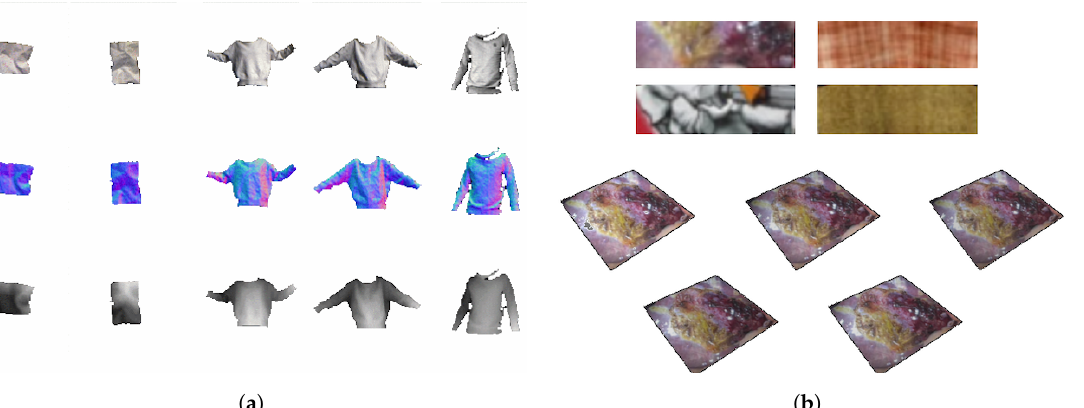
Figure 2. Examples of images in the datasets of Bednarik et al. [3] and Golyanik et al. [5], which are used to evaluate some of the networks in this paper. ( a ) The textureless surfaces dataset [3] contains RGB images and corresponding normal and depth maps for 5 different real objects. ( b ) The synthetic point cloud dataset of Golyanik et al. [5] has a deforming thin plate rendered with 4 different textures under 5 different